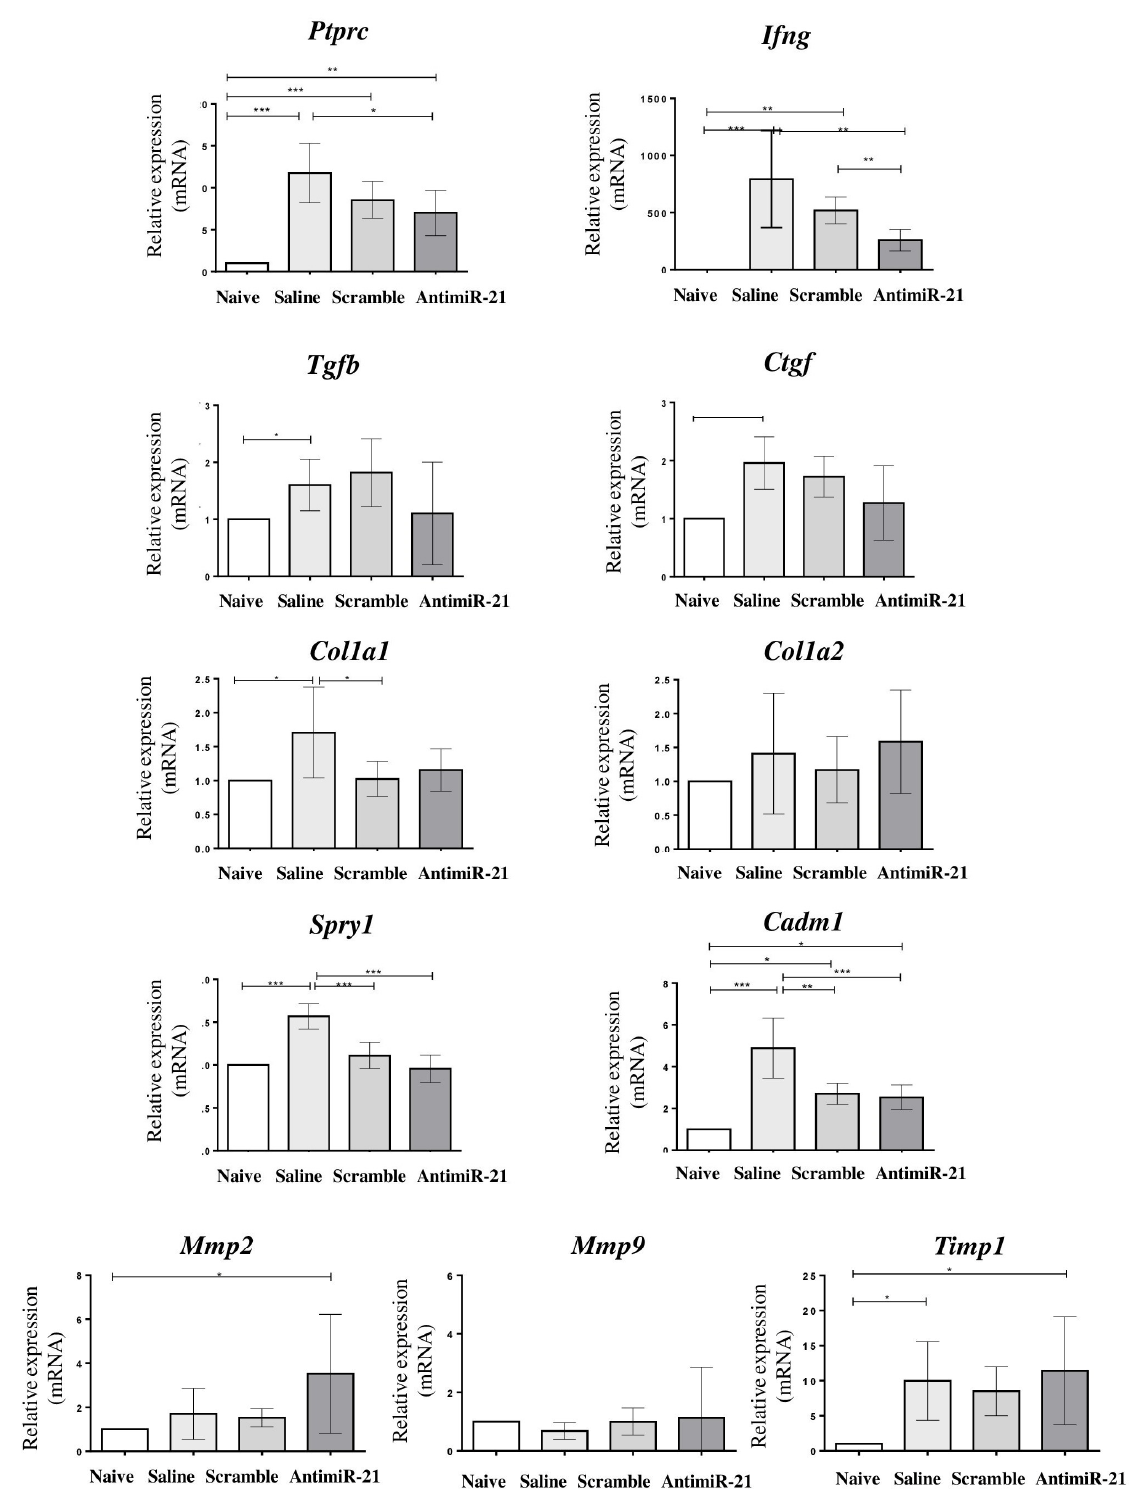
Figure 7. mRNA expression after treatment with LNA miR-21 inhibitor in chronic chagasic mice. Cardiac expression levels of Ptprc , Ifng , Tgfb1, Ctgf, Col1a1 , Col1a2 , Spry1, Cadm1, Mmp2, Mmp9 and Timp1 evaluated by RT-qPCR. Data are represented as mean ± SEM. n = 8 per group. ANOVA with Bonferroni comparisons. * p < 0.05. ** p < 0.01. *** p < 0.001.